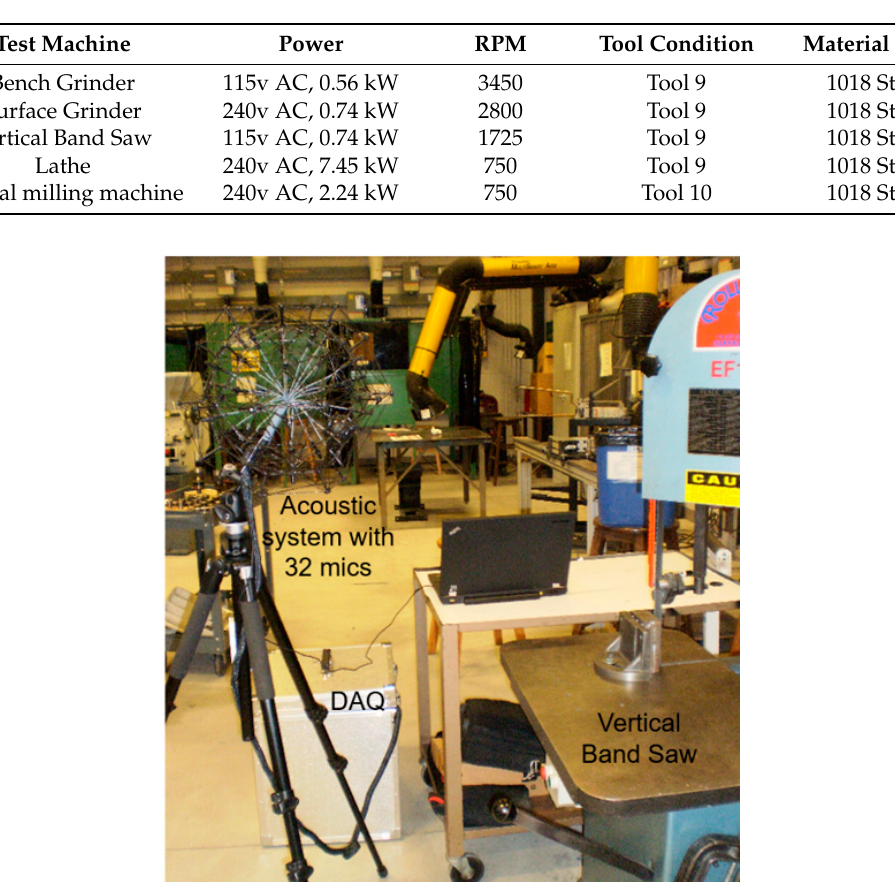
Table 2. Conditions for experiments (Tool condition on a scale of 10–0: Tool 10 (new tool) and Tool 0 (worn tool).